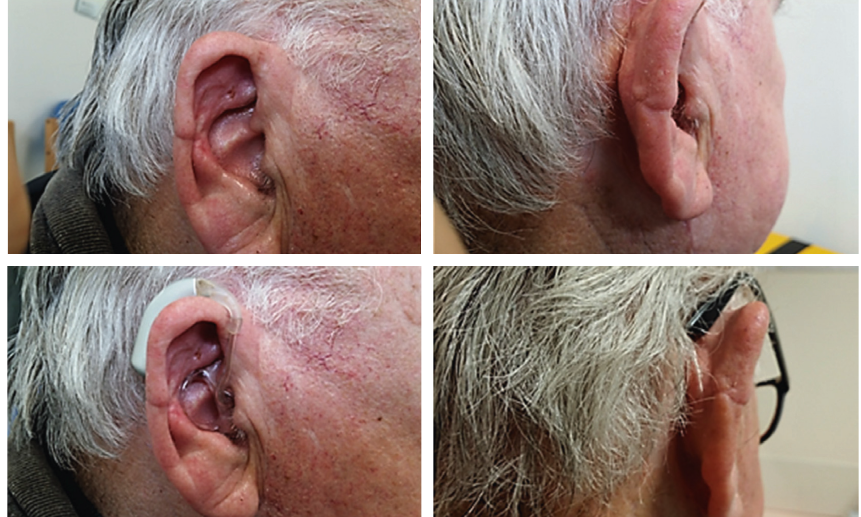
Figure 10: Clinical photographs showing the right pinna appearance at the most recent 4-month follow-up. The wound has healed well with successful grafting. The patient is comfortably able to wear his hearing aids and